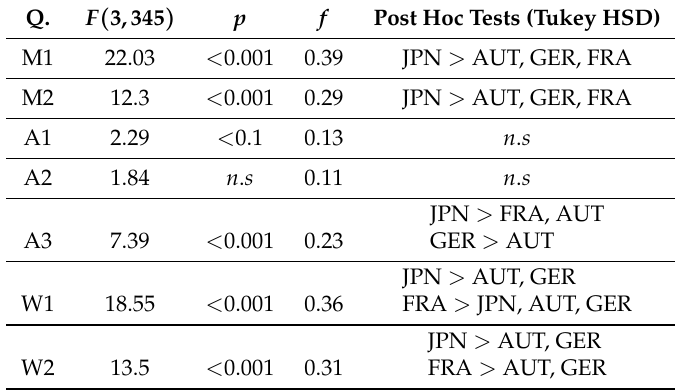
Table 2. Summary of scores for impressions about the android. HSD: honest significant difference.